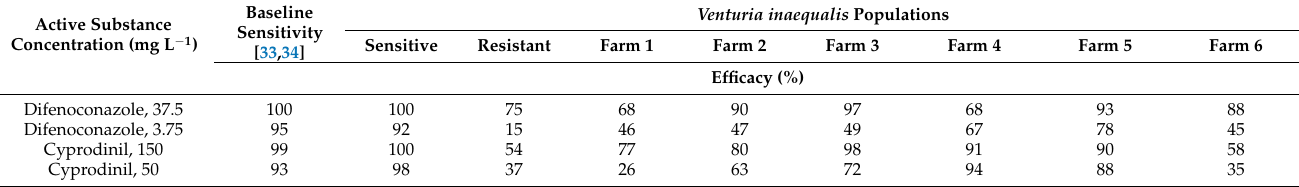
Table 6. Baseline sensitivity and efficacy of the difenoconazole and cyprodinil after curative applica- tion against sensitive and resistant Venturia inaequalis population and populations collected in six